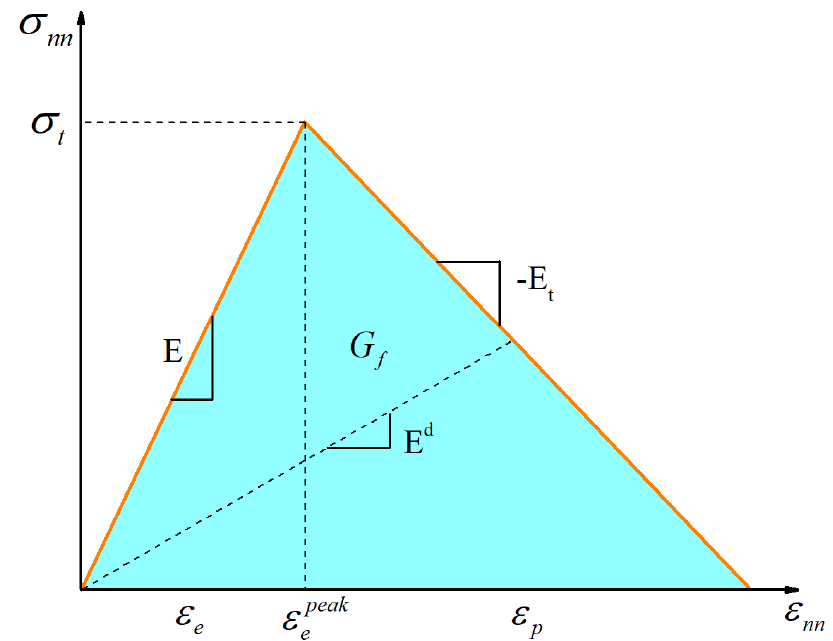
Figure 3. The stress − strain curve of discrete crack model.